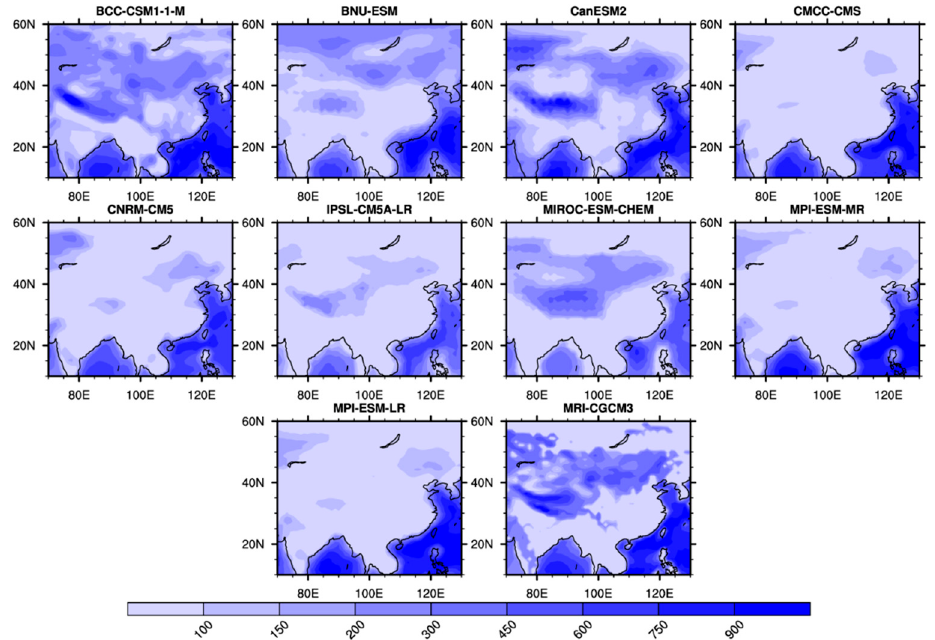
Figure A4. Spatial distribution of projected mean wind power density (WPD) in W / m 2 based on 90 m above ground level extrapolated wind speed for the 2041–2060 for the CMIP5 models under RCP8.5 scenario.